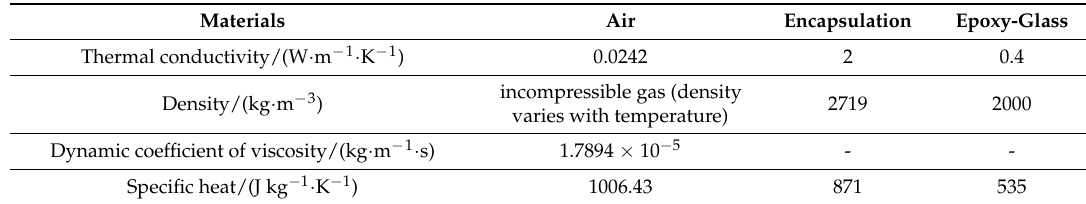
Table 1. Parameters of the